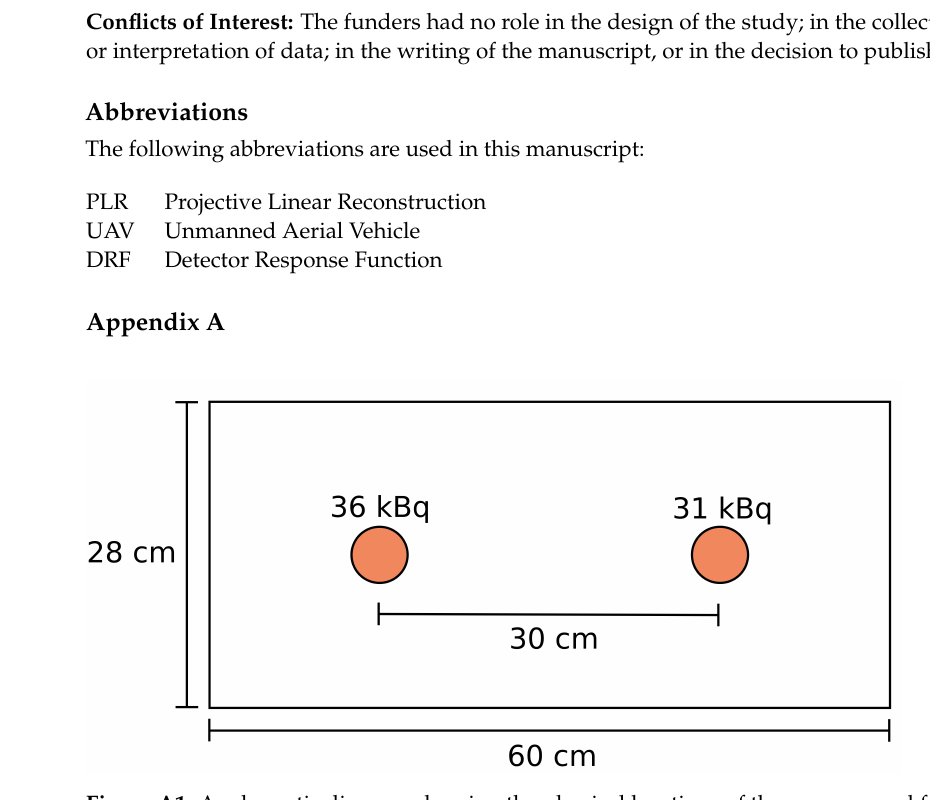
Figure A1. A schematic diagram showing the physical locations of the sources used for scenario 1.